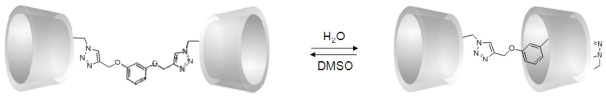
Schematic representation of the rotaxane-like self-complexation via a single glucose rotation of CD dimer 14 [33].